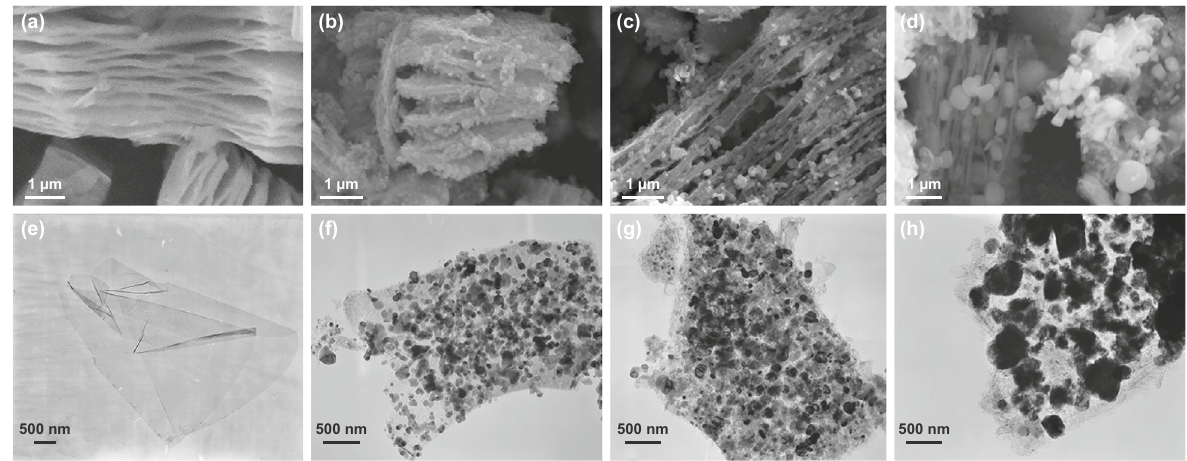
Fig. 3 SEM and TEM images of Ti 3 C 2 T x ( a , e ), S6 ( b , f ), S7 ( c , g ), and S8 (e , h